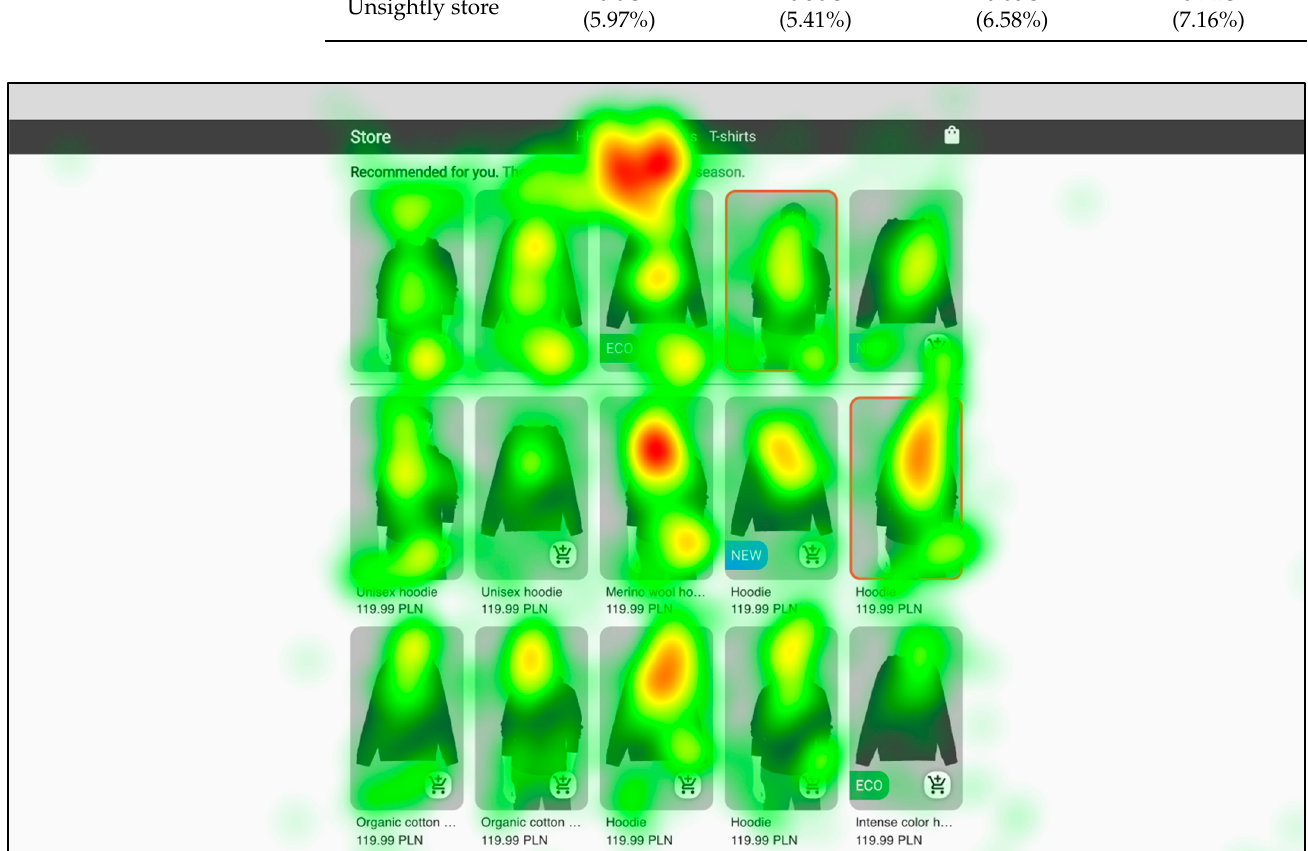
Figure 6. Aggregated heatmap for all participants for the first category (hoodies or skirts) in the aesthetic store. (The pictures of clothes and models are illustrative).